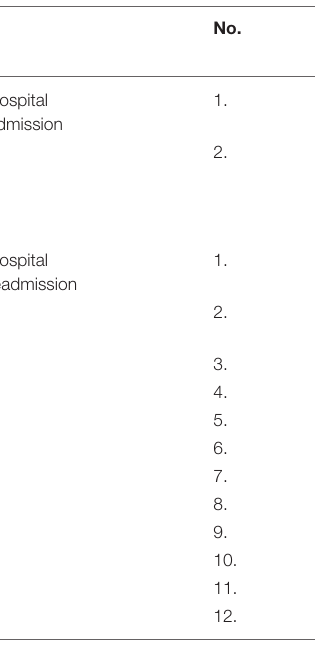
TABLE 5 | Predictors of hospitalization.